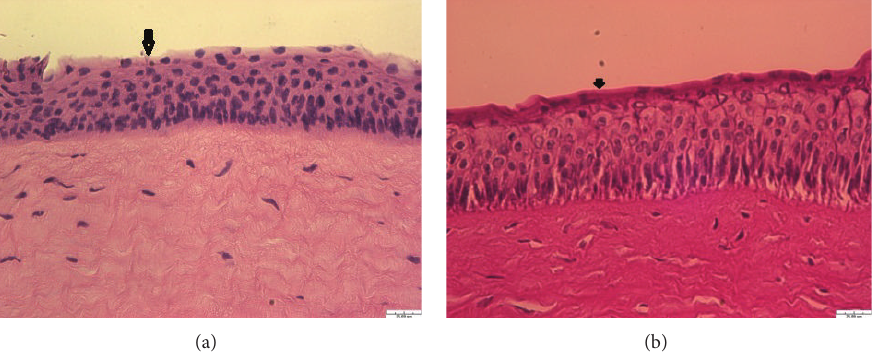
Figure 6: Micrographs of HE staining after 24 h treatment with PBS (a) and NLC + 2% HP 𝛽 CD (b). Arrow indicates the epithelium. Scale bar represents 25 𝜇 m. Porcine cornea after 24 h treatment was fixed, stained, and observed using light